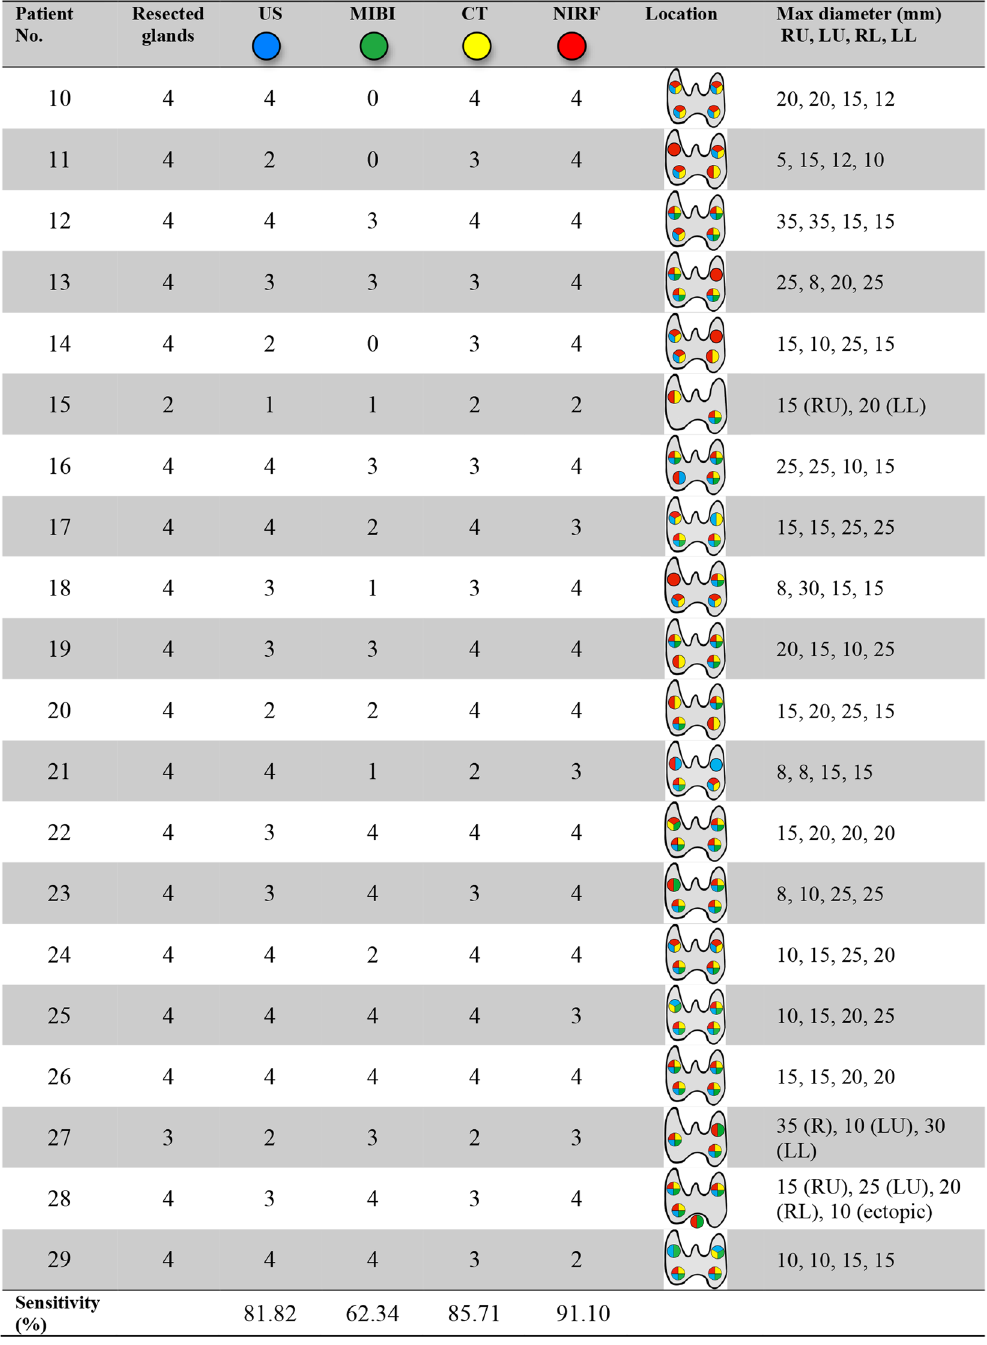
between administration and imaging. Another cause of this situation is the poor specificity of ICG to parathyroid glands. Unlike antibody binding to an antigen showing the specificity, ICG could also accumulate in other tissues due to the lack of active targeting, resulting in a high background signal and a low SBR. Differences in contrast are mainly due to differences in retention of the dye within tissues and variability in clearance. Active targeting groups, such as antibodies coupling ICG, will be a good strategy to settle this problem. The conjugation of ICG with antibodies that combines the optical properties of ICG with the specific recognition ability of the antibodies to the antigens on the surface of tumor cells has made some progress. For instance, some proteins such as integrin, VEGF, and HER-2, are overexpressed on the surface of tumor cells compared with normal cells. Many studies have utilized these antibodies to conjugate with ICG and have achieved excellent effects for tumor imaging 41–43 . These studies may provide an approach to solve the specificity of ICG to the parathyroid gland in the future.